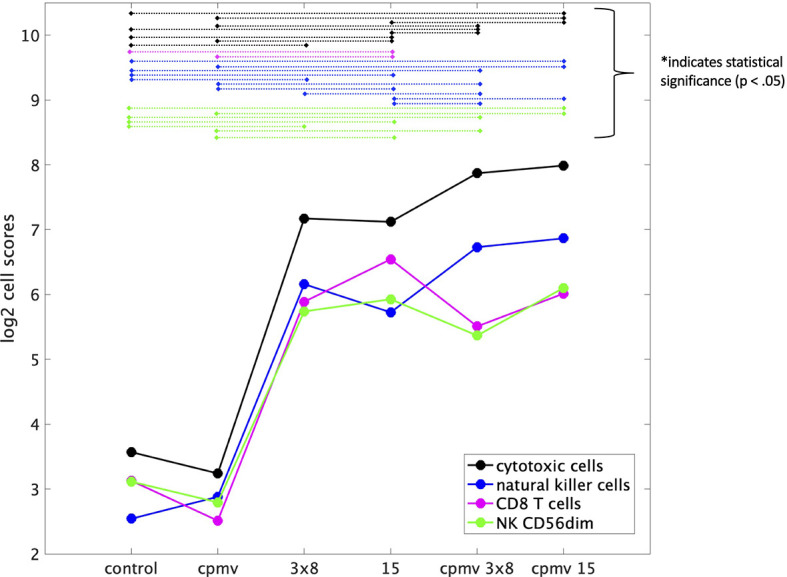
Immune Cell Abundances (mRNA). Cell type scores calculated using reference genes specific to certain cell types, for a variety of immune cell populations versus treatment cohorts. These scores (in the log2 space) represent cell abundance and allow for comparison of abundance across various treatments. Both cytotoxic and natural killer cells appear to have an increase of about 1 on the cell type score from 15 Gy to Cowpea mosaic virus (CPMV)/15 Gy indicating a two-fold increase in these cell populations. There is also an increase from 3x8 Gy to CPMV/3x8 Gy, but it is not as large as that between the 15 Gy cohorts. Statistical significance between groups is indicated by the dashed lines connecting the two treatment groups, as labeled.